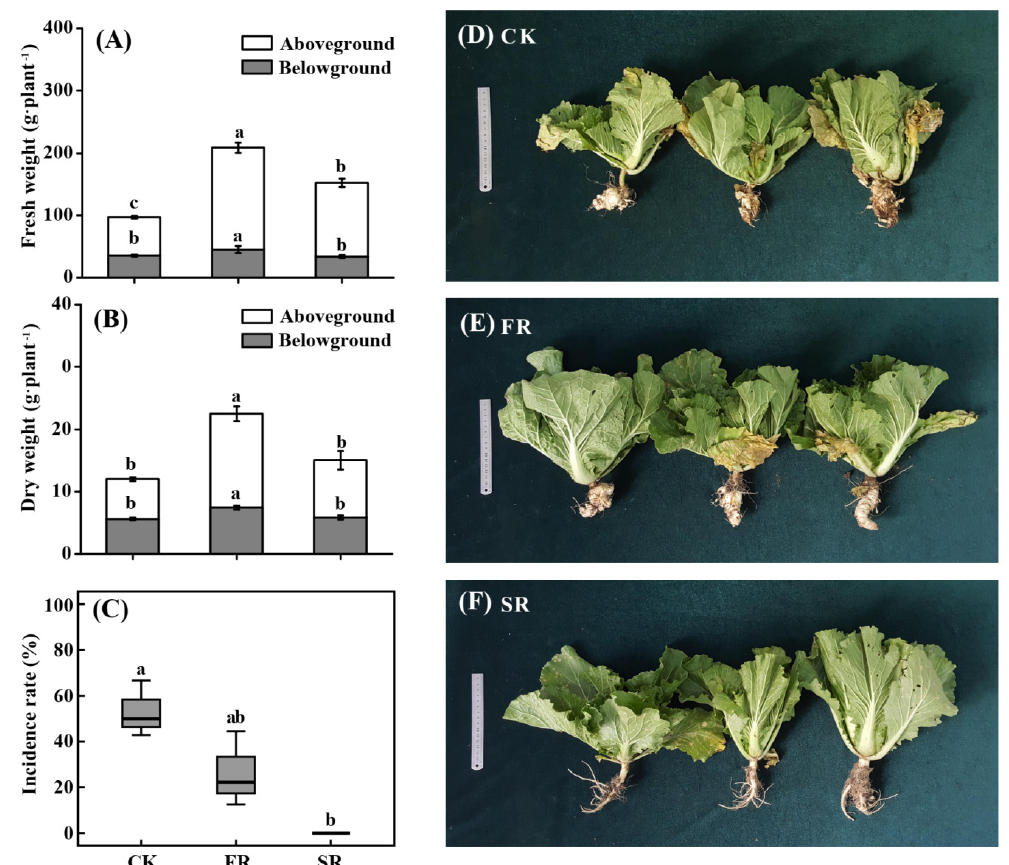
Figure 1. Plant weight and clubroot incidence rate in response to straw application. ( A ) Fresh weight. ( B ) dry weight, ( C ) incidence rate of clubroot and ( D – F ) Chinese cabbage plant after harvest. CK, no straw application; FR, one-year straw application; SR, two-year straw application. Error bars indicate the standard error, and different letters indicate significant differences at the 0.05 level (Tukey’s HSD test).